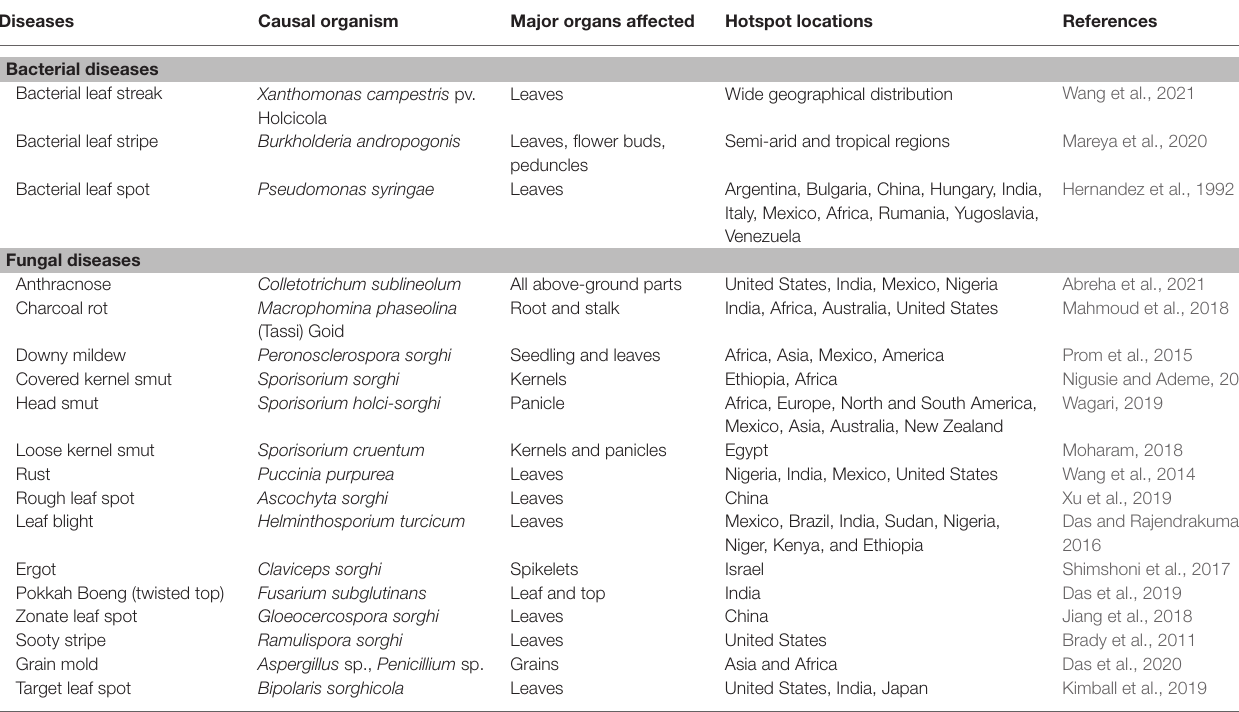
TABLE 5 | An overview of various diseases caused in sorghum following biotic